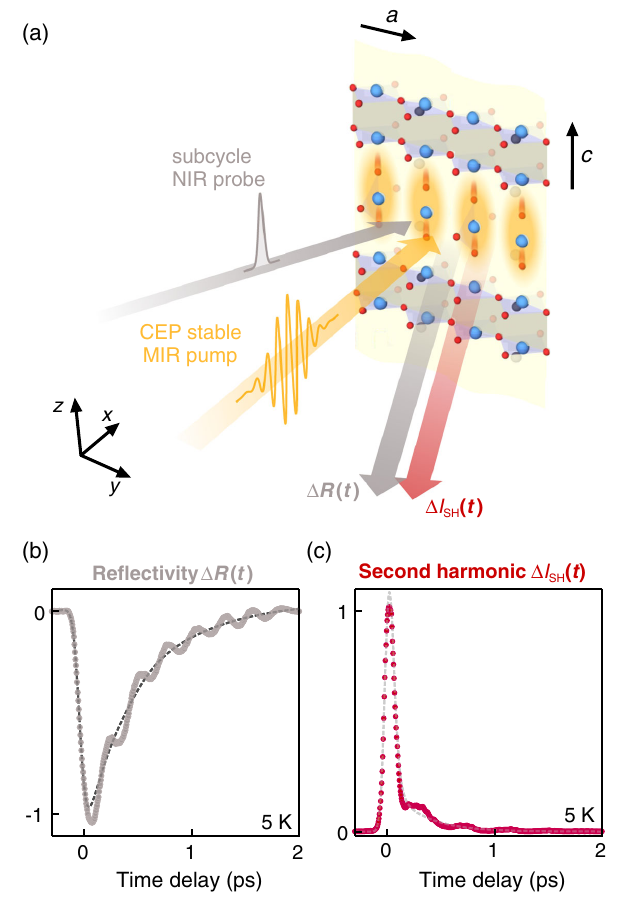
FIG. 1. (a) Schematic of the pump-probe geometry. The 800-nm near-IR probe (gray) and CEP stable mid-IR (MIR) pump (yellow) pulses were polarized along the YBa 2 Cu 3 O 6 crystal ’ s c -axis and . 48 perpendicular to the CuO 2 planes. The resonantly excited apical oxygen vibrations are shaded in yellow. Light at the fundamental (gray arrow) and second-harmonic (red arrow) frequency is reflected from the sample. (b) Time-resolved changes of the linear reflectivity at 800-nm wavelength, showing coherent modulations due to fully symmetric Raman phonon modes. (c) Time-resolved second-harmonic intensity at 400-nm wavelength (red circles) and a numerical fit to the nonoscillatory component of the signal (dashed line). The data in (b) and (c) are shown for 5-K base temperature and 7-MV/cm peak excitation